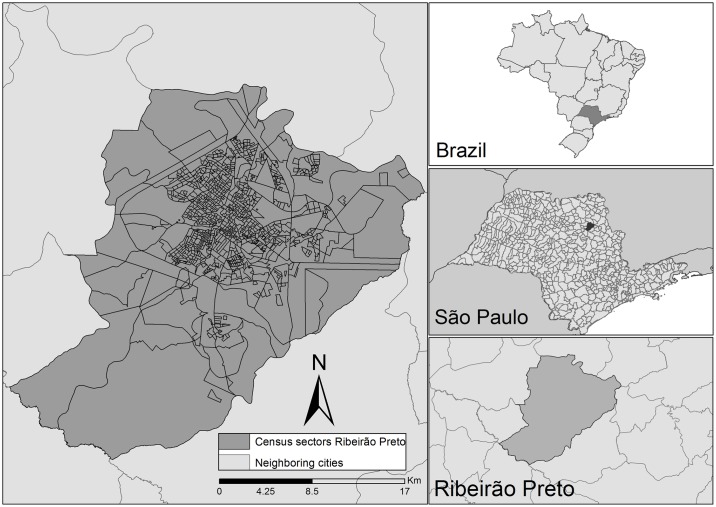
Map showing the location of the city in the state of São Paulo, Brazil (2006–2013).